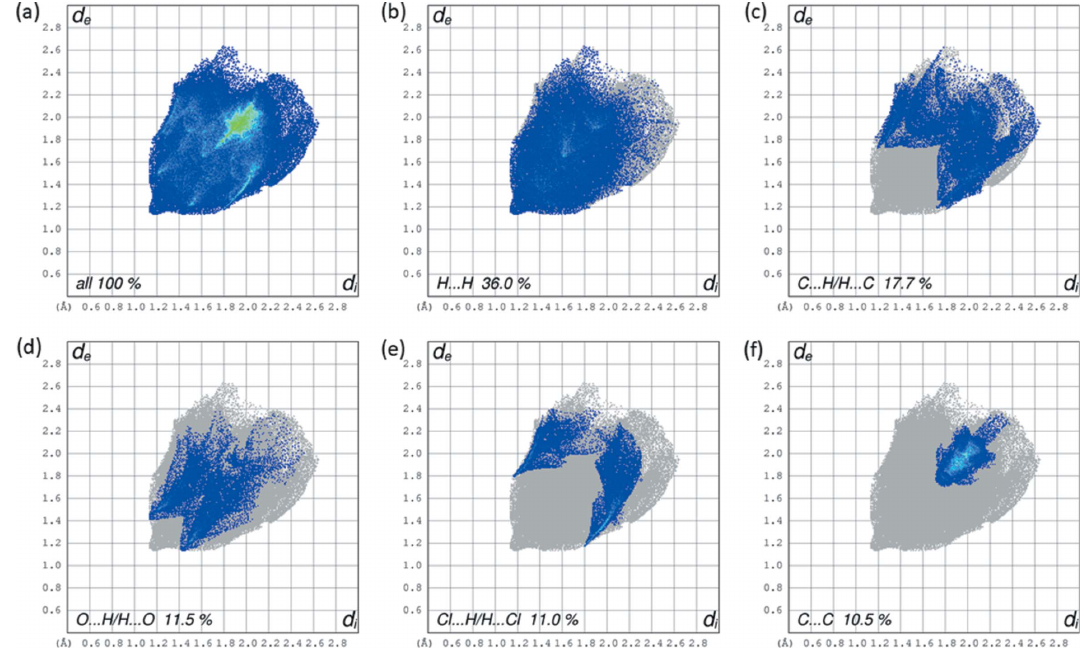
Figure 6 ( a ) The full two-dimensional fingerprint plot for the title compound and those delineated into ( b ) H (cid:3)(cid:3)(cid:3) H, ( c ) C (cid:3)(cid:3)(cid:3) H/H (cid:3)(cid:3)(cid:3) C, ( d ) O (cid:3)(cid:3)(cid:3) H/H (cid:3)(cid:3)(cid:3) O, ( e ) Cl (cid:3)(cid:3)(cid:3) H/ H (cid:3)(cid:3)(cid:3) Cl and ( f ) C (cid:3)(cid:3)(cid:3) C contacts.